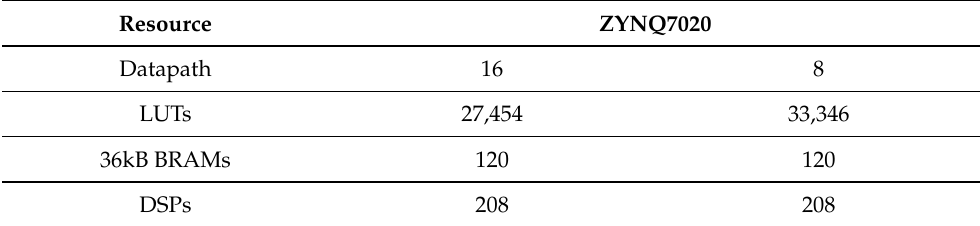
Table 6. Resource utilization in a ZYNQ7020